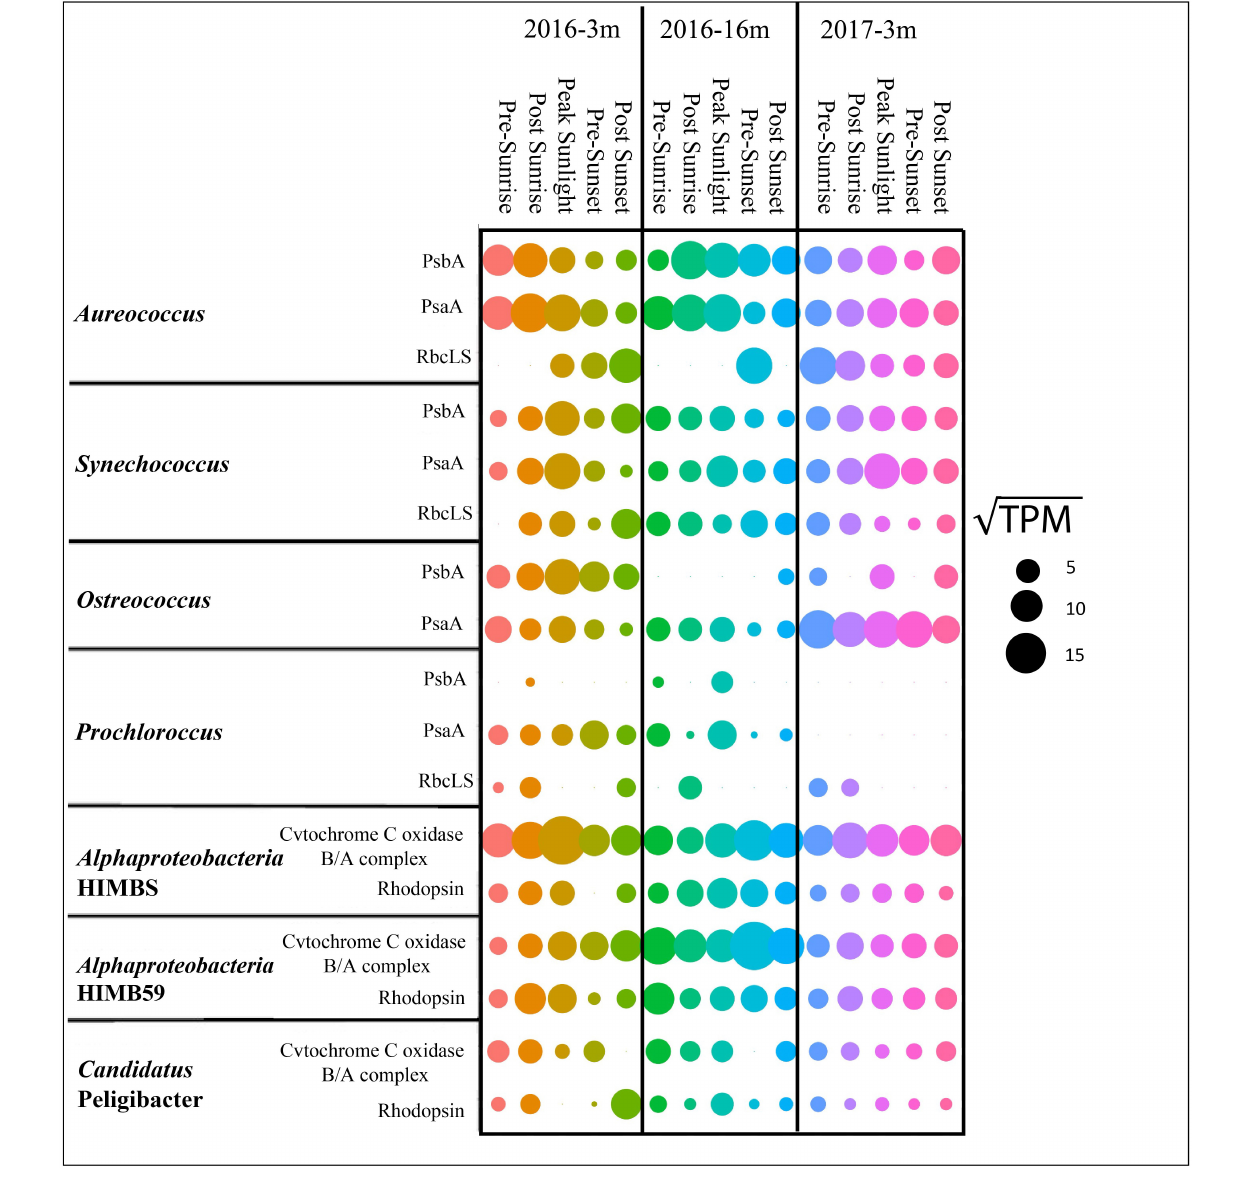
FIGURE 3 | Dot plot showing gene expression in ln(TPM) for genes products annotated as photosystem I, photosystem II, RbcLS, cytochrome C oxidase B/A complex, and rhodopsins in the photic layers of each cruise for dominant organisms ( Aureococus , Synehcococcus , Ostreococcus , Prochlorococcus , Alphaproteobacteria HIMB5, Alphaproteobacteria HIMB59, and Candidatus Pelagibacter). The colors in the figure are to help differentiate time